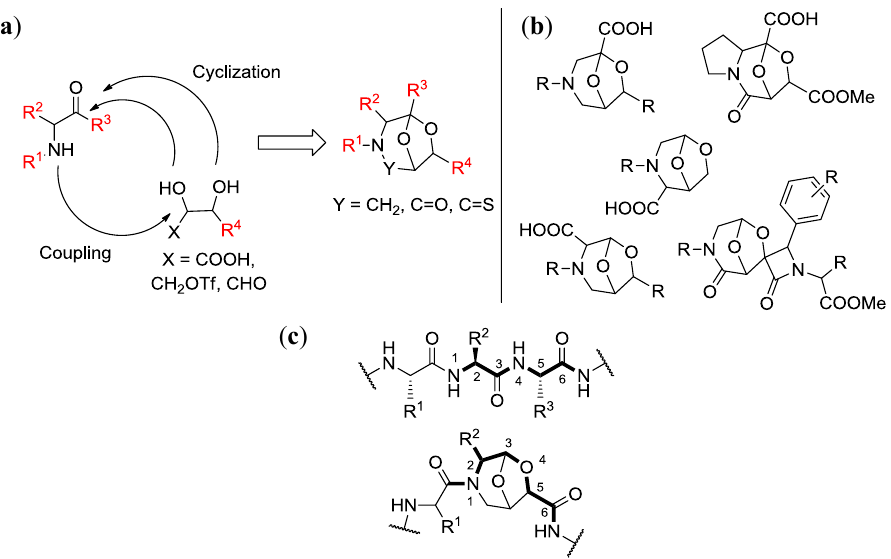
Figure 6. ( a ) Strategic approaches for the synthesis of peptidomimetic scaffolds starting from sugar and amino acids derivatives; ( b ) Representative examples of bicyclic rigid scaffolds obtained with this strategy; ( c ) 6,8-dioxa-3-azabicyclo[3.2.1]octane scaffold as a constrained dipeptide isostere